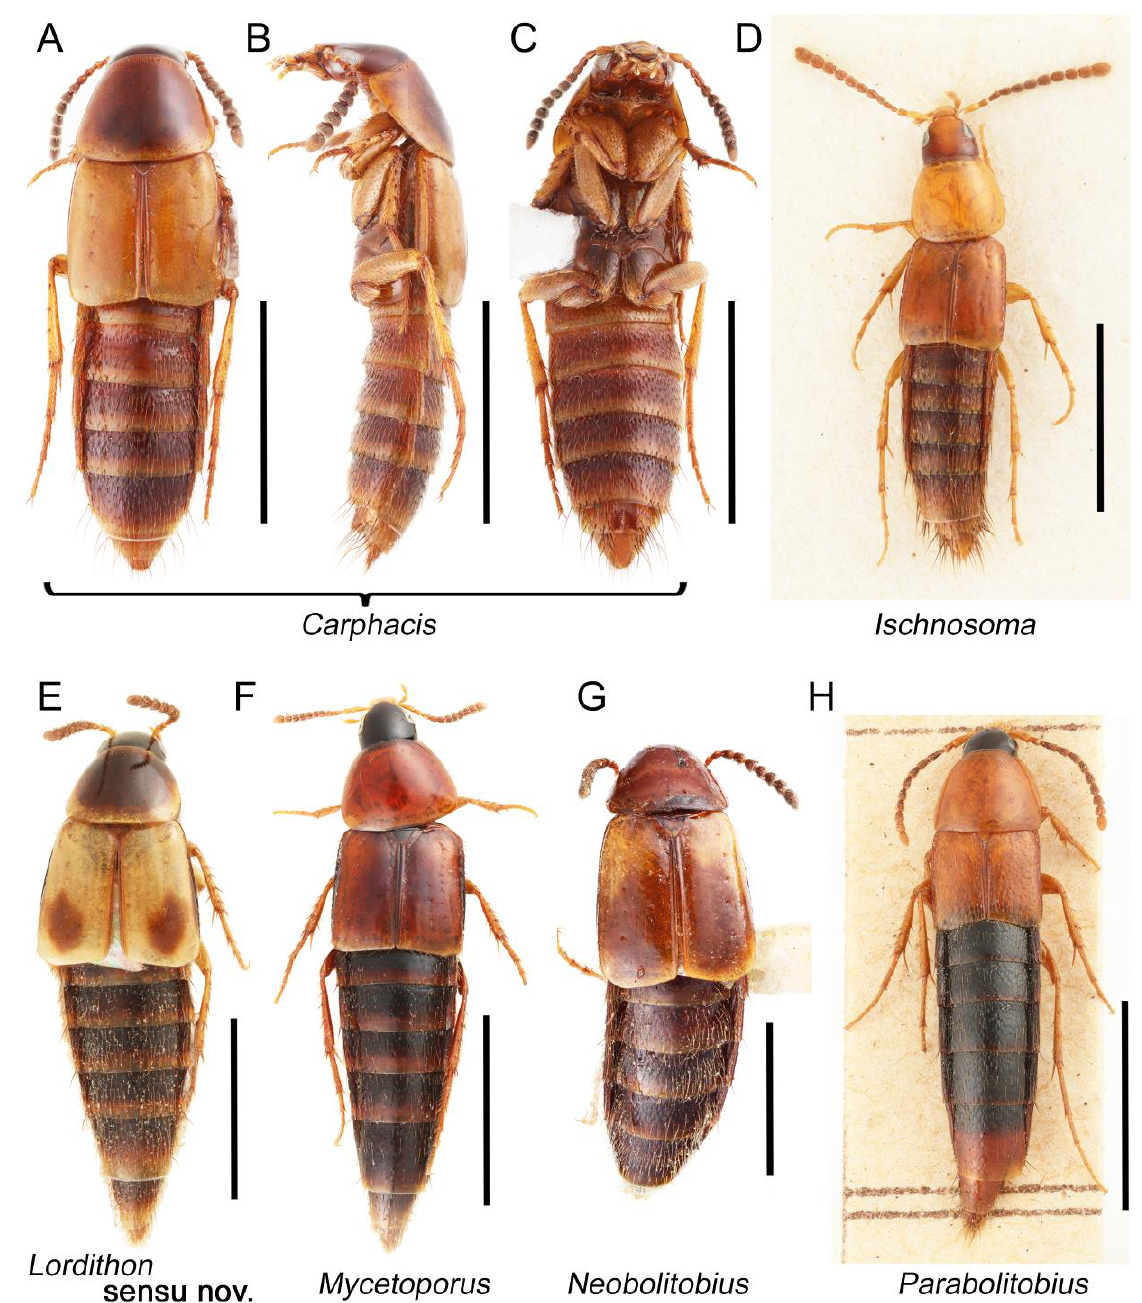
Figure 63. Habitus photographs of Mycetoporinae. ( A ) Carphacis effrenatus Herman, dorsal view. ( B ) Carphacis effrenatus , lateral view. ( C ) Carphacis effrenatus , ventral view. ( D ) Ischnosoma splendidum (Gravenhorst), dorsal view. ( E ) Lordithon thoracicus thoracicus (Fabricius), dorsal view. ( F ) Mycetoporus punctus (Gravenhorst), dorsal view. ( G ) Neobolitobius varians (Hatch), dorsal view. ( H ) Parabolitobius formosus (Gravenhorst), dorsal view. Scale bars: 2.0 mm ( A – C , F ); 1.5 mm ( D , E , G ); 3.0 mm ( H